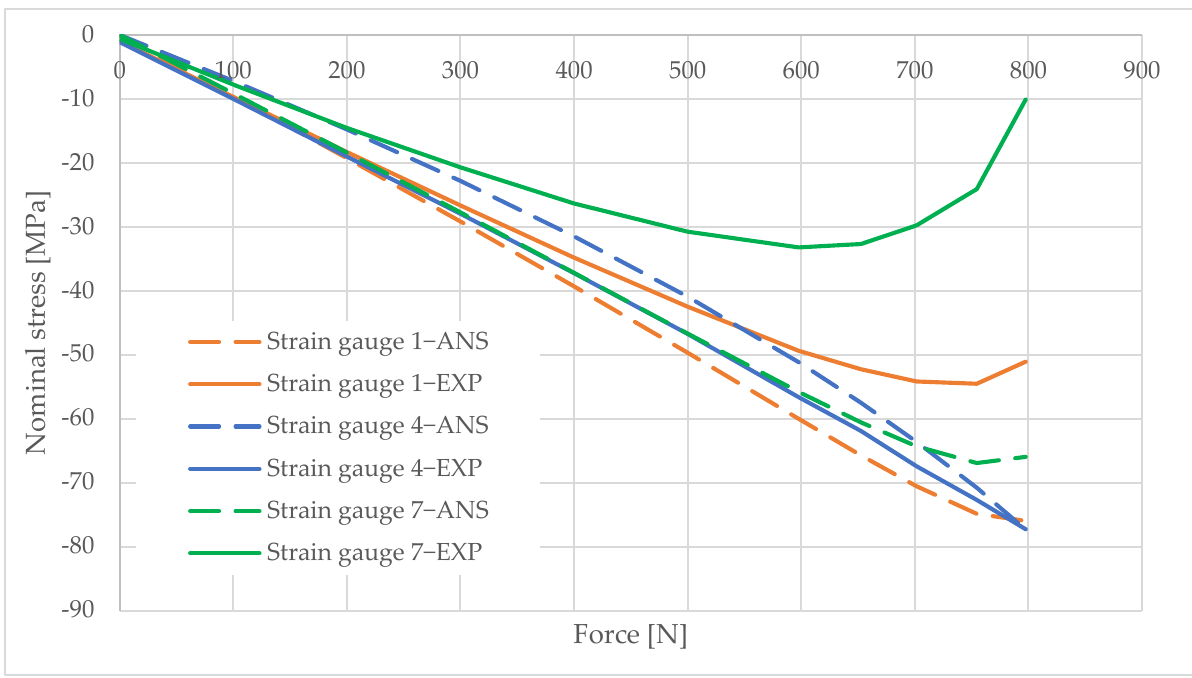
Figure 15. Pole 9/1 — values of normal stress readings from strain gauges no. 11 and 12.